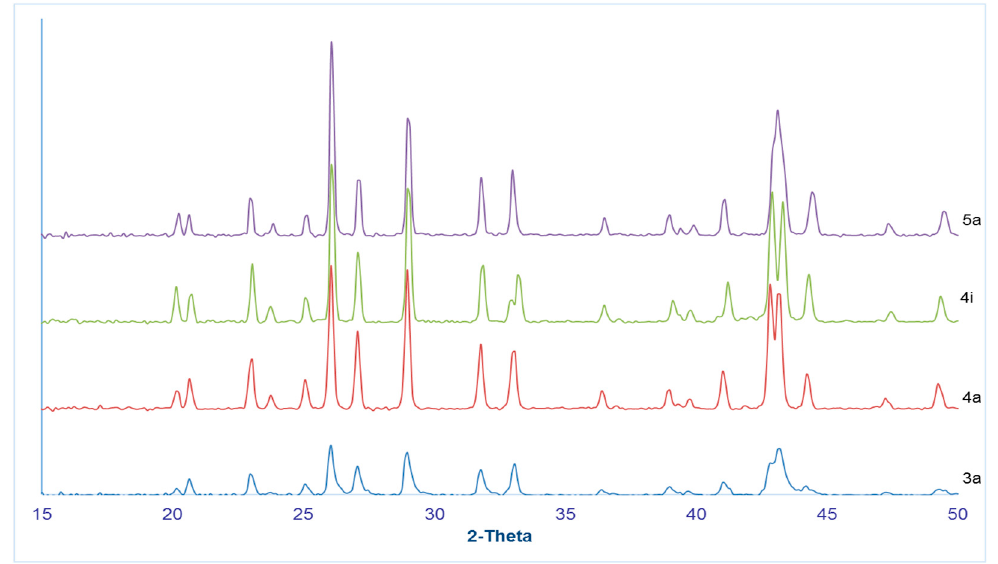
Figure 2. XRD patterns of the four distinct synthetic barite crystal morphologies: well-rounded crystals (sample 3a), rosette crystals (sample 4a), elliptical crystals (sample 4i), and euhedral crystals (sample 5a). Table 2. D-spacing calculated from XRD patterns of the four distinct synthetic barite crystal morphologies: well-rounded crystals (sample 3a), rosette crystals (sample 4a), elliptical crystals (sample 4i), and euhedral crystals (sample 5a). The barite and celestine standards were taken from Antao [47].